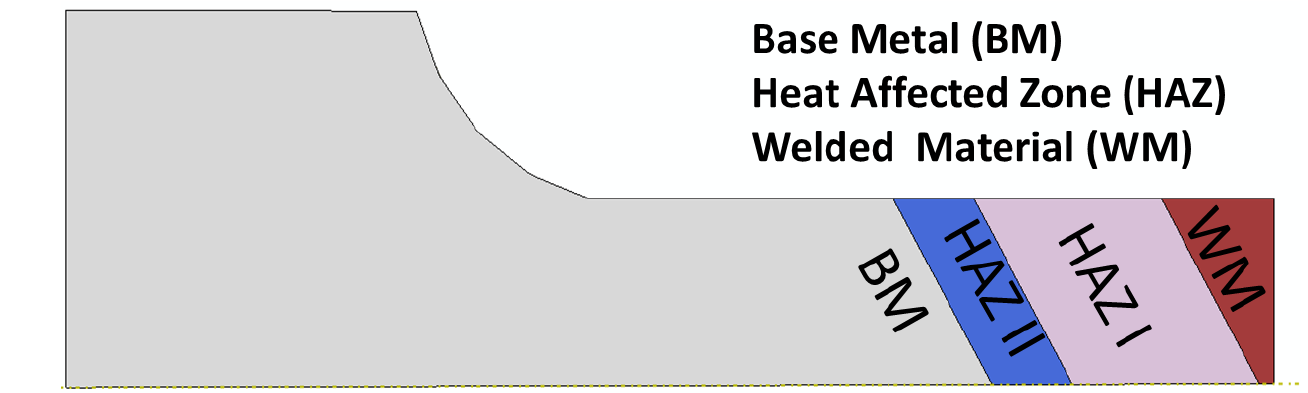
Figure 4. Schematic representation of the welded specimen, showing the Base Metal (BM), Heat Affected Zone I and II (HAZ I and II), and the Welded Material